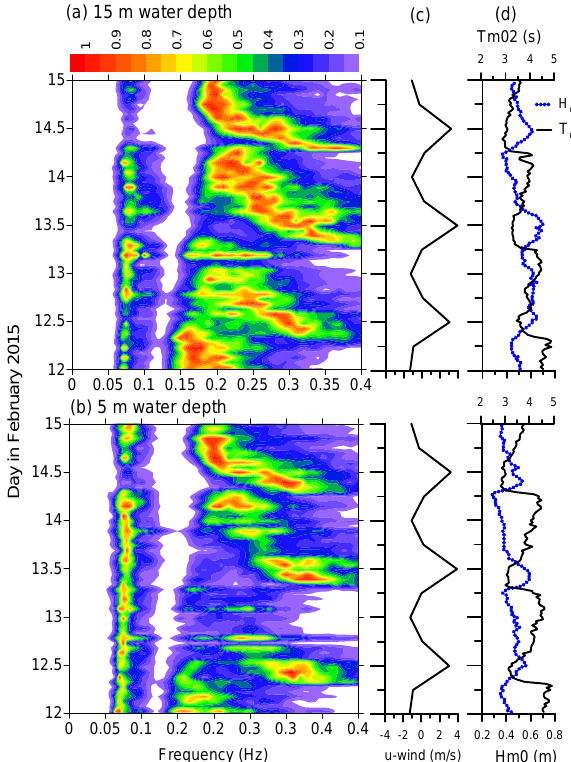
Figure 12. Growth of wave spectrum with sea breeze during 12– 14 February 2015 (a) at 15m water depth and (b) at 5m water depth. Swells are also present at both locations. Normalised spec- tral energy density is presented. Plot (c) is the temporal variation of cross-shore wind (u-wind) and (d) is temporal variation of signifi- cant wave height and mean wave period.